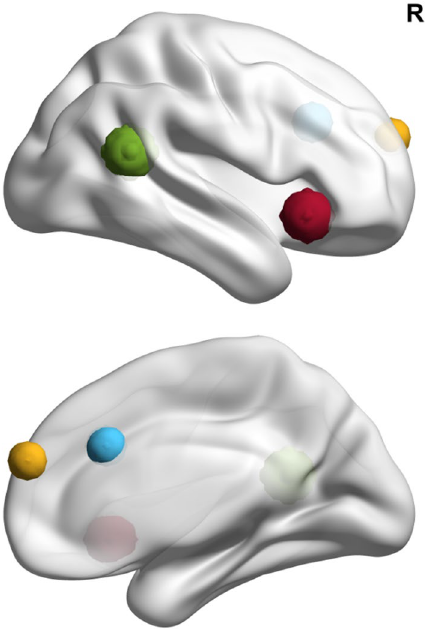
Figure 3. Regions of Interest selected based on Neurosynth survey (only ROIs in the right hemisphere are visualized, ROIs in the left hemisphere were roughly symmetrical, see “fMRI analysis” section for details). AI— red, TPJ—green, dACC—blue,